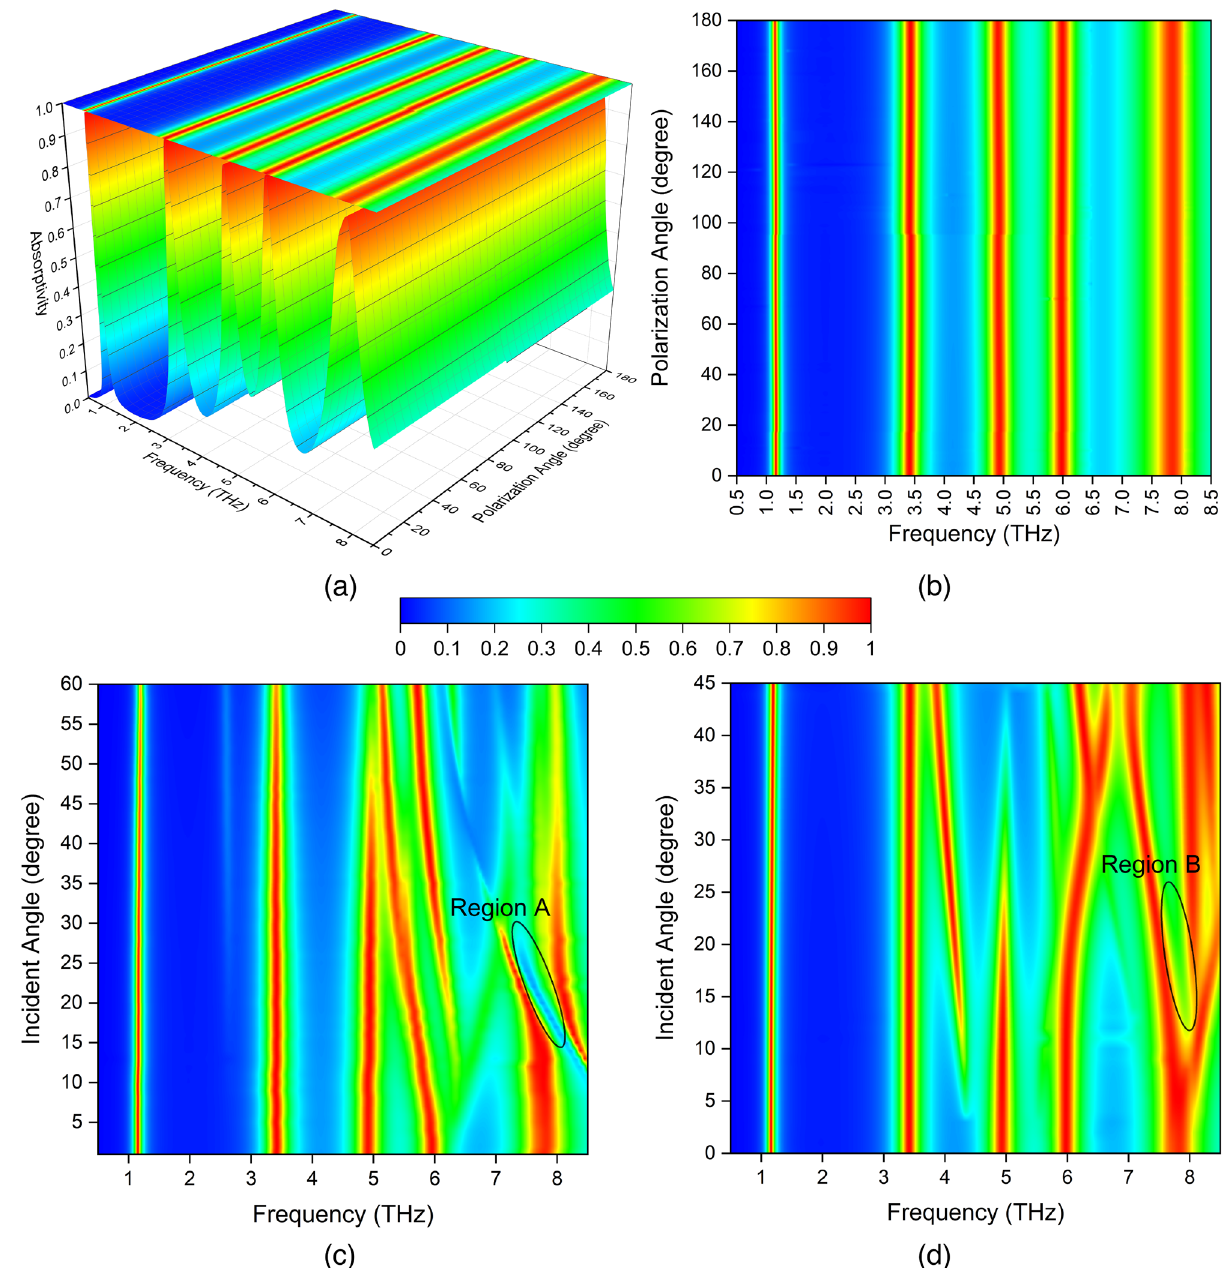
Figure 4. ( a ) 3-D contour plot of the absorption spectra of the proposed metamaterial absorber for polarization angle ( φ ) ranging from 0 ◦ to 180 ◦ with 1 ◦ sweeping for normal incidence. ( b ) 2-D contour plot of the absorption spectra. ( c ) 2-D contour plots of the absorption spectra upon the different incident angles ( θ ) for TE and ( d ) TM